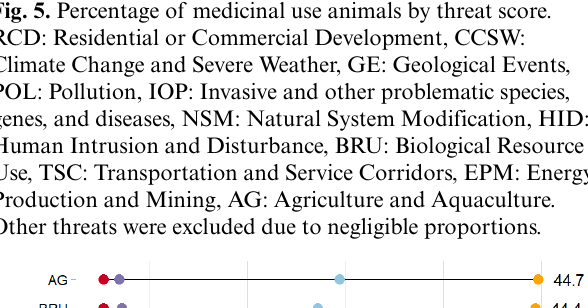
Fig. 5. Percentage of medicinal use animals by threat score.